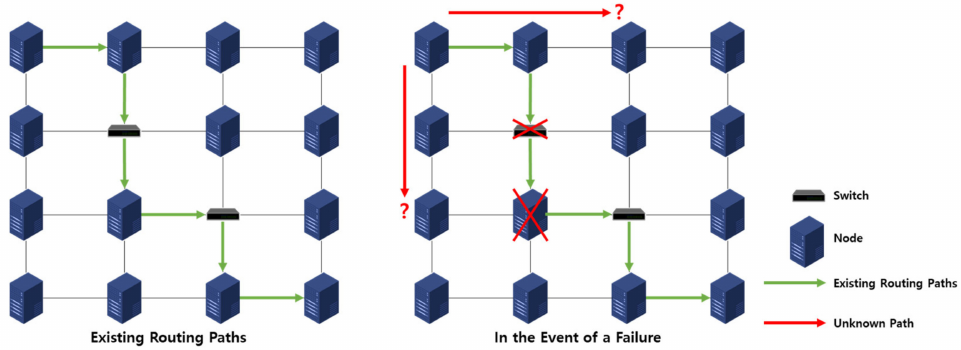
Figure 5. Example of a failure in a network routing